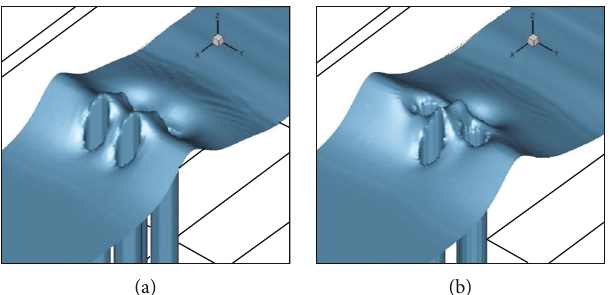
Figure 5: A three-dimensional free-surface elevation at the maximum run-up of the cylinder 1 for H / h = 0 : 25 : (a) square arrangement; (b) diamond arrangement.